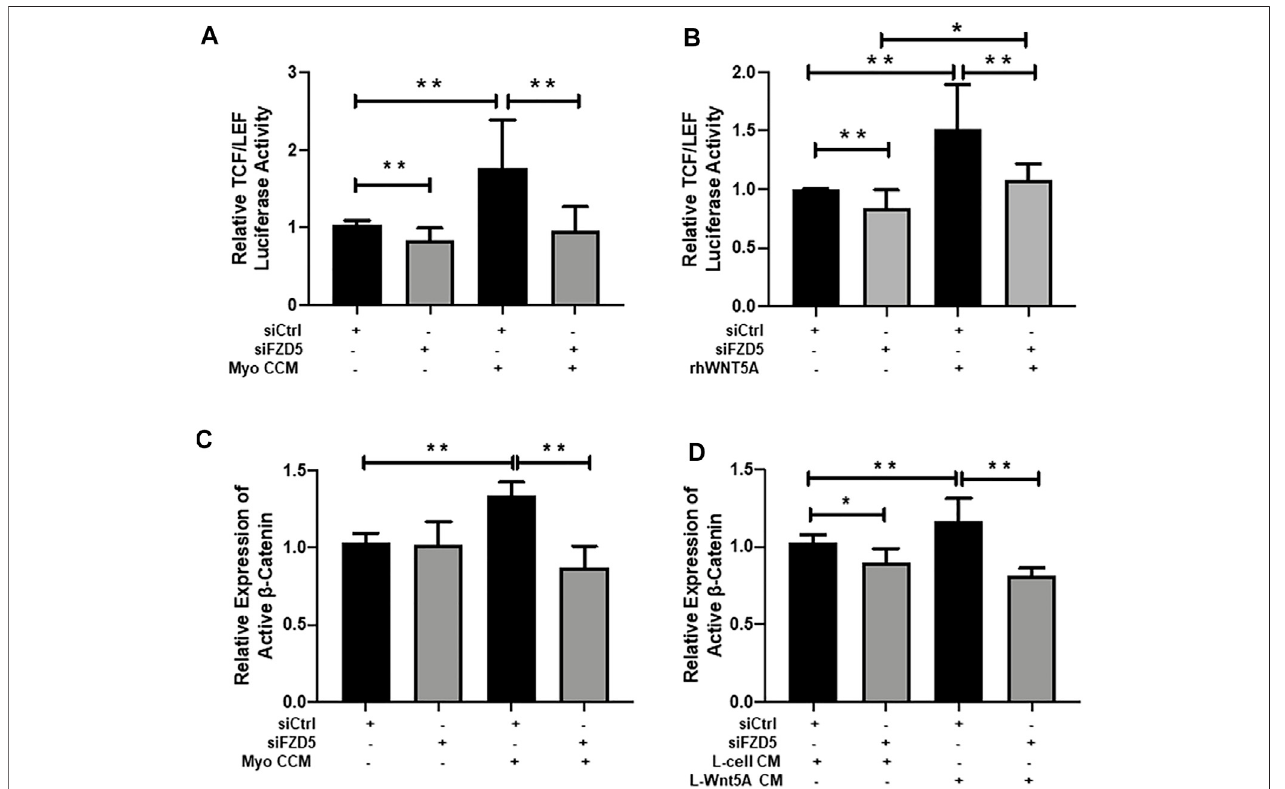
FIGURE 4 | Effect of FZD5 silencing on WNT/ β -catenin signaling. (A) The TCF/LEF luciferase activity of eMSC after transfection with scrambled control siRNA (siCtrl) (black bars), siRNA directed toward FZD5 (siFZD5) (gray bars) and cultured in myometrial CCM after transfection with siCtrl or siFZD5 (n = 6). (B) The TCF/LEF luciferasesignalofeMSCaftertransfectionwithscrambledcontrolsiRNA(siCtrl)(blackbars),siRNAdirectedtowardFZD5(siFZD5)(graybars)andculturedwith0.01 μ g/ mlofrhWNT5AaftertransfectionwithsiCtrlorsiFZD5(n=6). (C) Relativeexpressionofactive β -cateninineMSCaftertransfectionwithorwithoutmyometrialCCM (n=5,normalizedto β -actin). (D) Relativeexpressionofactive β -catenin ineMSCafter transfectionwithorL-cellWnt5aCM(n=5).Resultsarepresentedasmean±SD; * p < 0.05, ** p < 0.01. Abbreviations: Myo CCM, myometrial concentrated conditioned medium; rhWNT5A, human recombinant WNT5A; eMSC, endometrial mesenchymal stem-like cells; FZD,